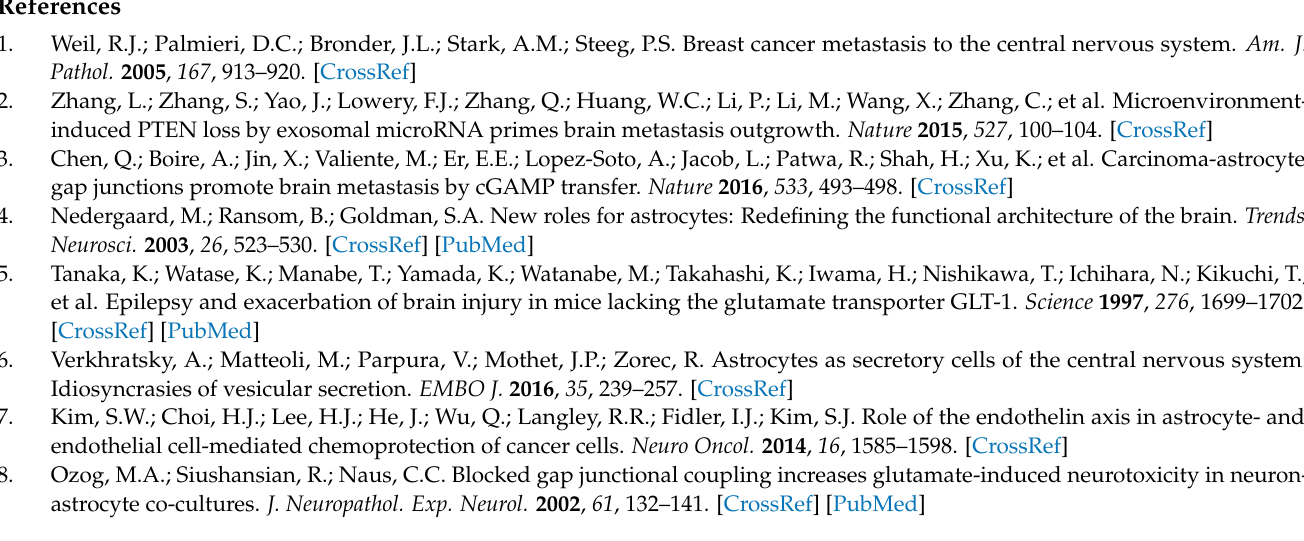
metabolites for statistics, Table S6: MDA231 heatmap and PCA, Table S7: MDA231 pathway_results. Figure S1: Proportional association between MDA231 (eGFP +) cell count and fluorescent